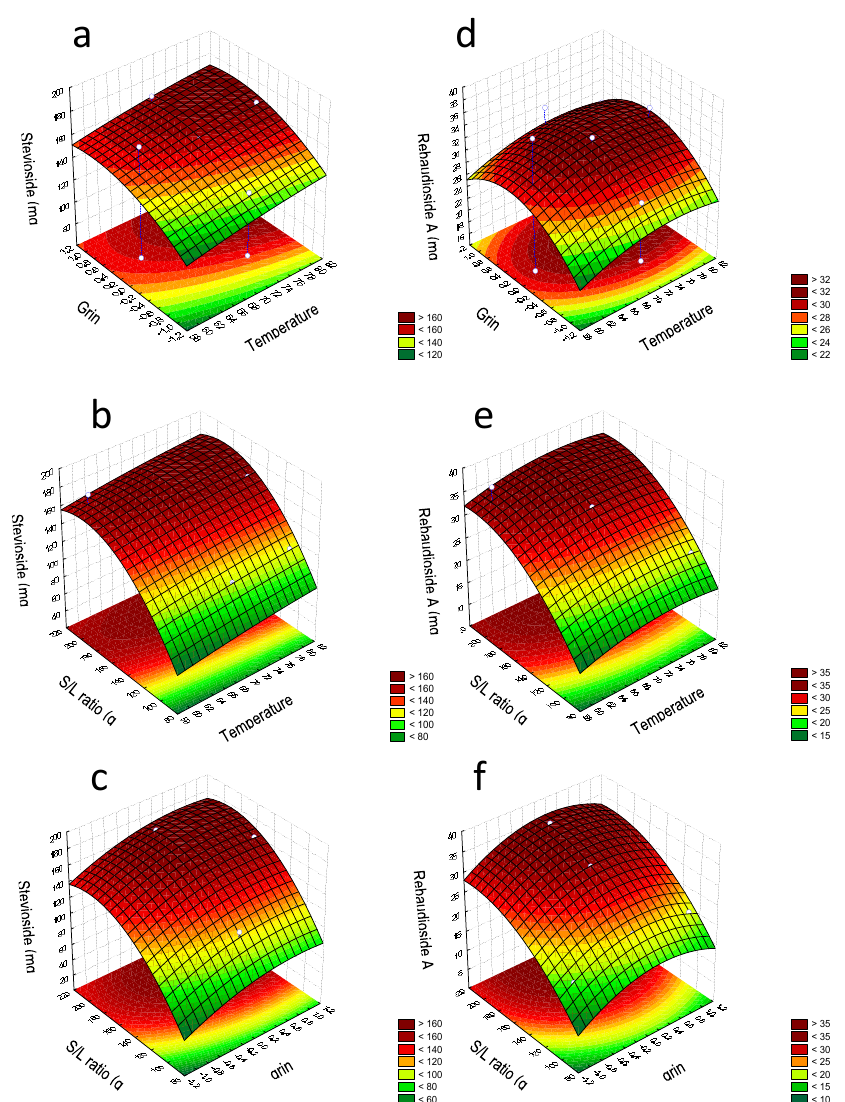
Figure 1. Response surface plots showing the effects of factors on Stevioside ( a – c ) and rebaudioside A ( d – f ) concentrations.